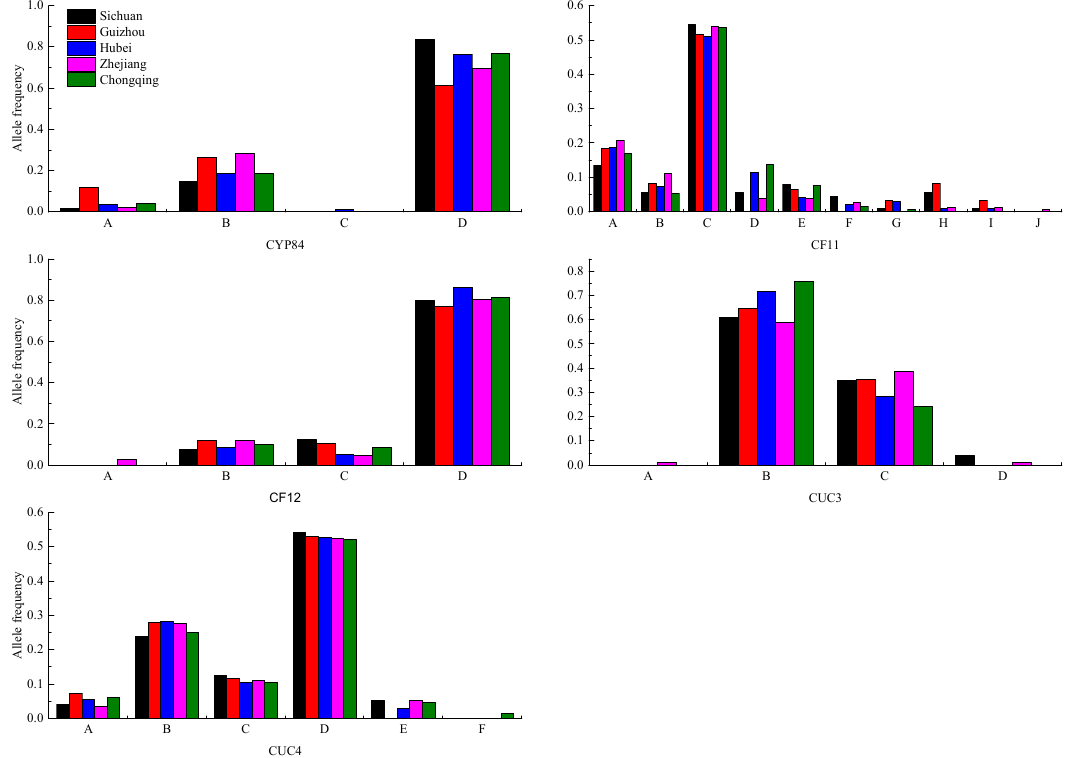
Figure 1. Five private alleles of 17 microsatellite loci in five populations.